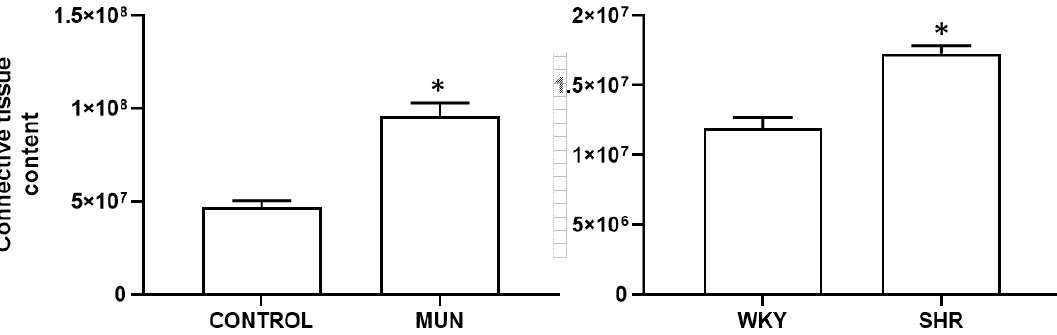
Figure 3. Histomorphometry of hypertensive (MUN and SHR) and normotensive (CONTROL and WKY) mesenteric arteries, stained with Trichrome. MUN, offspring exposed to maternal undernu- trition during pregnancy; CONTROL, offspring from mothers fed ad libitum during pregnancy; SHR, spontaneously hypertensive rats; WKY, Wistar Kyoto rats. Values are mean ± s.e.m. from 6 rats of each group. Significant differences from the respective control rat: * p < 0.05.